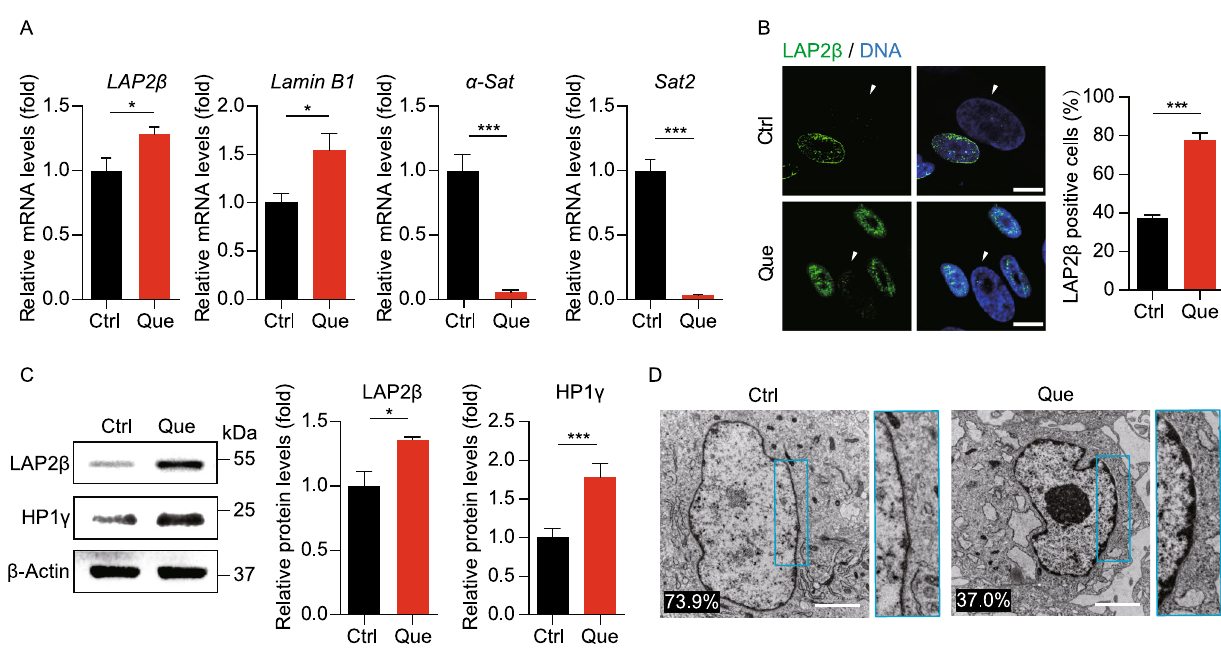
Figure 5. Que rejuvenated epigenetic features of WS hMSCs. (A) RT-qPCR analysis of LAP2 β , Lamin B1 , α -Sat and Sat2 mRNA levels in vehicle- and Que-treated WS hMSCs (passage 7). Data are shown as mean ± SEM ( n = 3). * P < 0.05 vs. Ctrl; *** P < 0.001 vs. Ctrl. (B) Immunostaining of LAP2 β in vehicle- and Que-treated WS hMSCs. White arrows indicate LAP2 β -negative nuclei. Quantitative data on the right are shown as mean ± SEM (cell number ≥ 300). *** P < 0.001 vs. Ctrl. Scale bar, 10 μ m. (C) Immunoblotting analysis of LAP2 β and HP1 γ in vehicle- and Que-treated WS hMSCs (passage 7). β -Actin was used as the loading control. Quantitative data are shown as mean ± SEM ( n = 3). * P < 0.05 vs. Ctrl; *** P < 0.001 vs. Ctrl. (D) Visualization of heterochromatin architecture of vehicle- and Que-treated WS hMSCs (passage 7) by transmission electron microscope (TEM). High- magni fi cation views of heterochromatin around nuclear envelope are shown on the right. The percentage of cells with sparse heterochromatin at nuclear periphery is indicated at the lower left corner of each representative image. Cell number > 100. Scale bar, 2